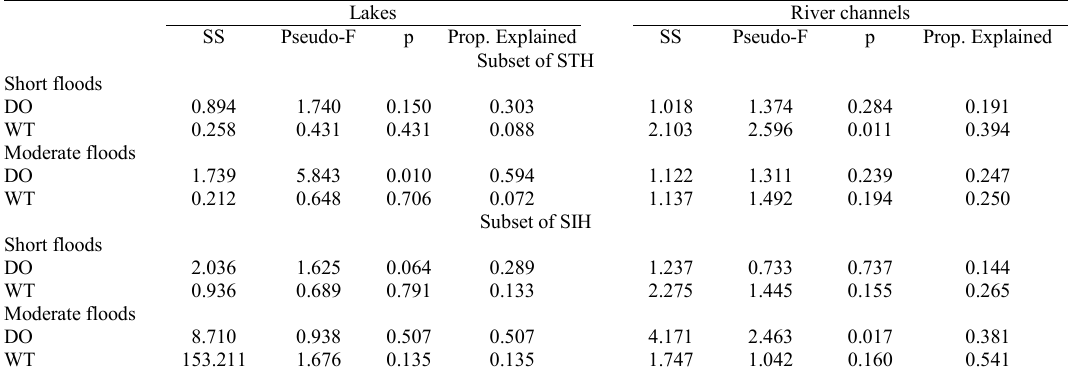
Table 3. Results of the multivariate regression models that fitted sequentially the explanatory variables dissolved oxygen and water transparency (DO and WT, respectively) in order to explain the composition of the subsets of STH and SIH in the upper Paraná River floodplain, between 2000 and 2003. SS = sum of squares; Pseudo-F = ratio associated to the variance between and within groups on the basis of the Chi-square measure of distance; p = probability of error obtained by permutation procedure; Prop. Explained = proportion of variance